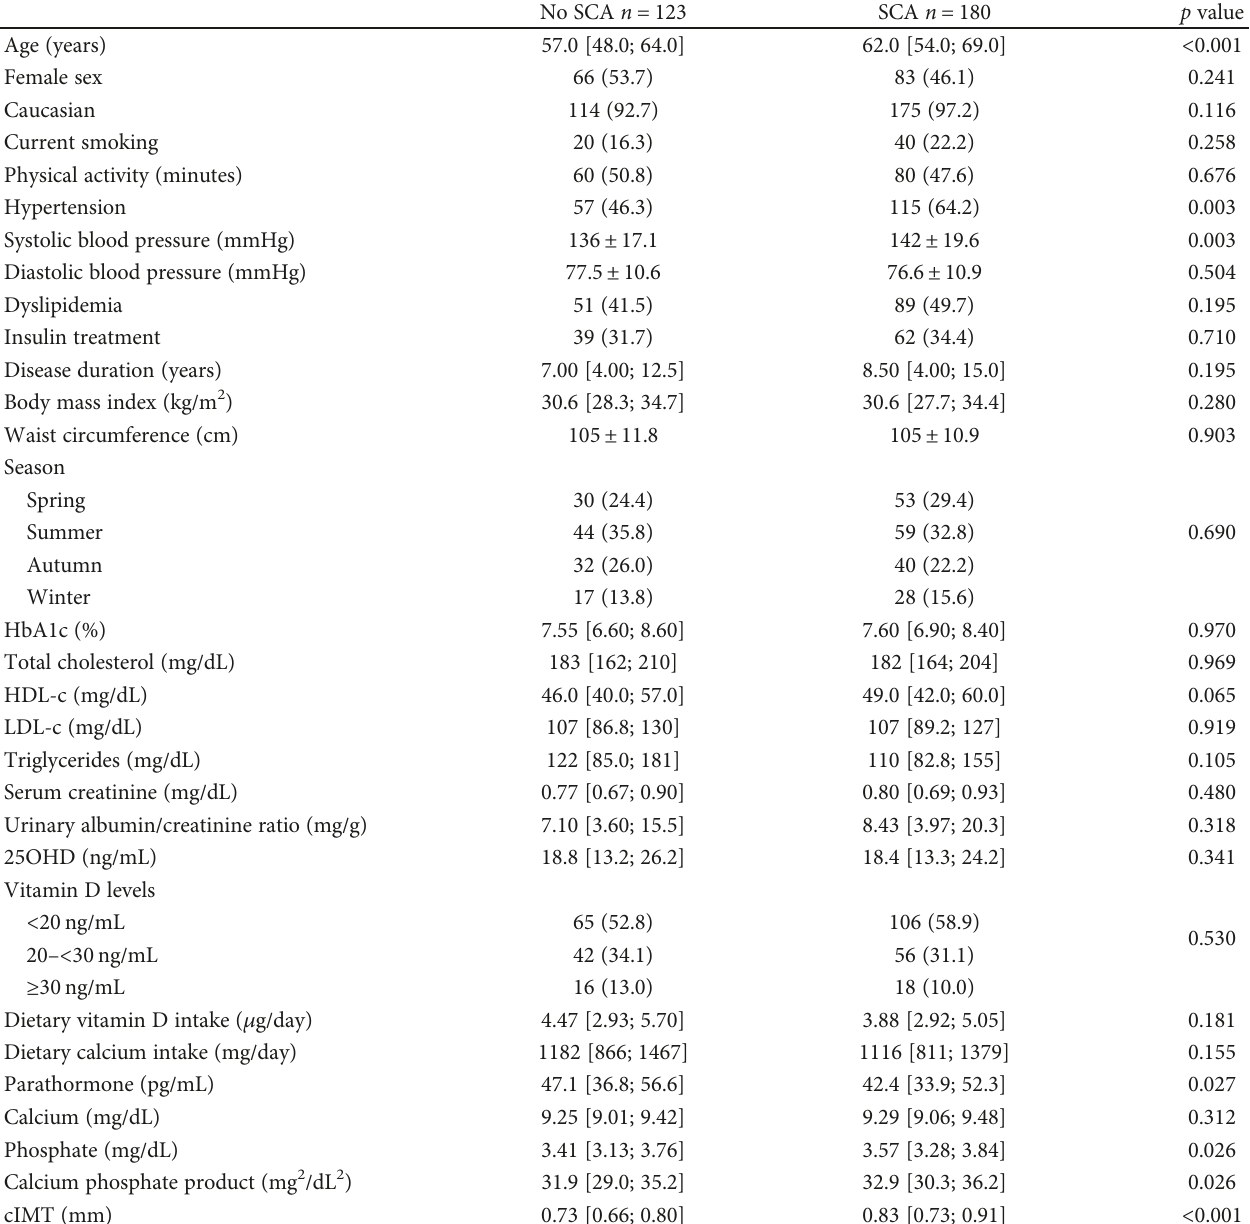
Table 1: Clinical and biochemical characteristics of patients with type 2 diabetes with and without subclinical carotid atherosclerosis